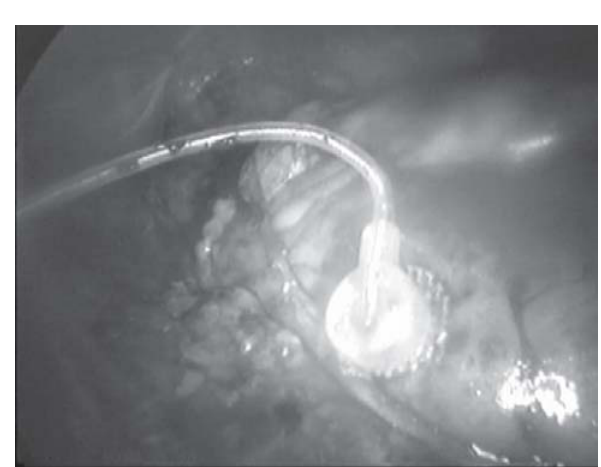
Fig. 3 – Visão endoscópica do eletrodo implantado em parede lateral de ventrículo esquerdo